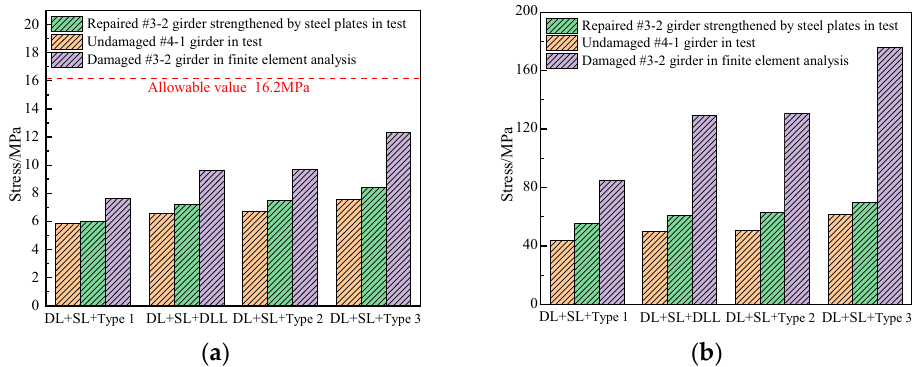
Figure 25. Stress comparison ( a ) Stress of concrete; ( b ) Stress of longitudinal steel bars.